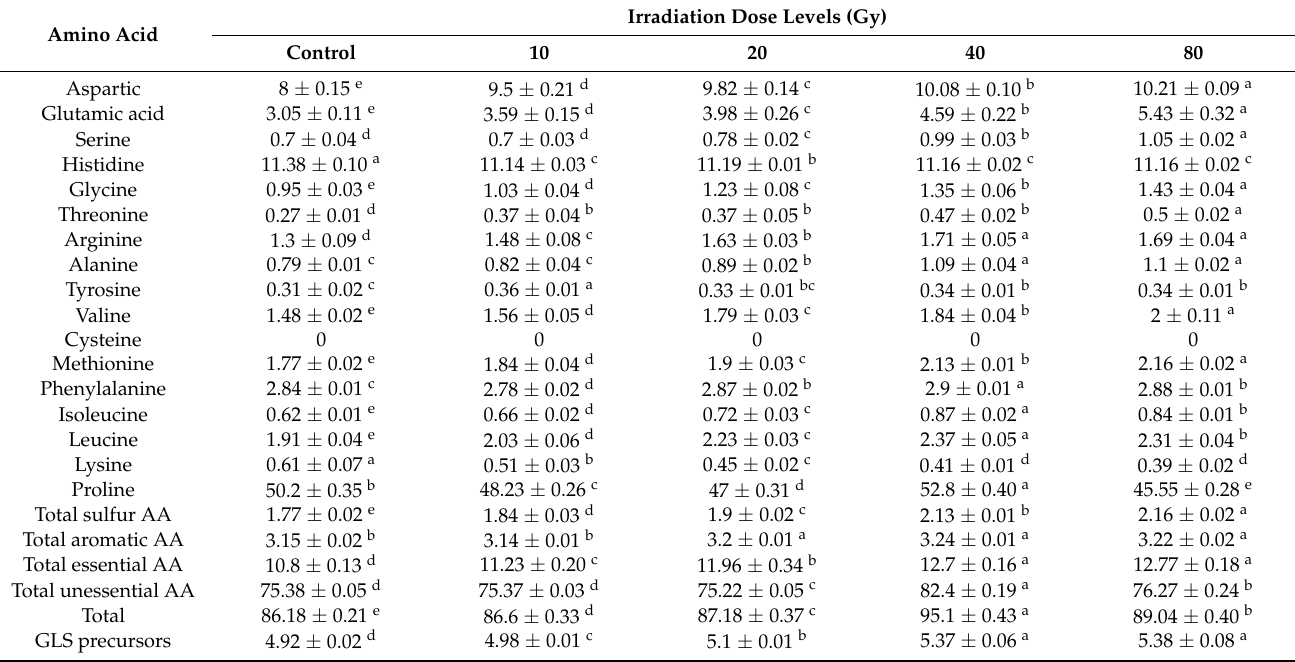
Table 5. Amino acid content ( µ g/g DW) of red radish roots affected by different doses of γ